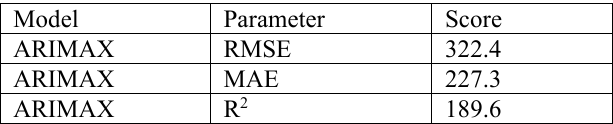
Figure 9. XGBoost Performance